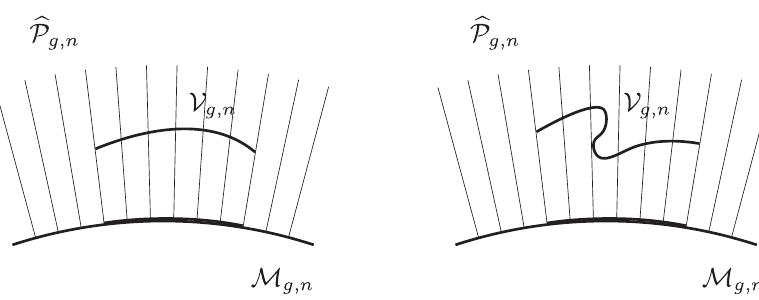
Figure 1 . Left: a string vertex V g,n that is a piece of a section over M g,n . Right: a string vertex V g,n that is not a piece of a section over M g,n . In both cases the projection π maps V g,n to its image with degree